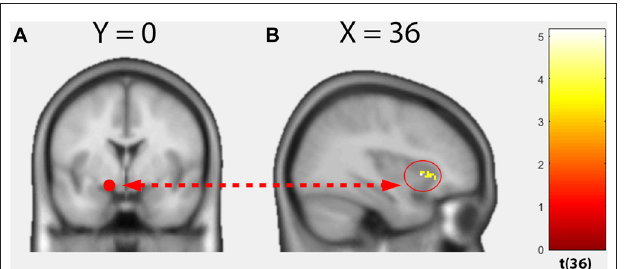
FIGURE 3 | Results of the voxel-wise regression psychophysiological- interactions (PPI) analysis. (A) Seed region, left dorsal amygdala. (B) Functional connectivity group difference varied as a function of the TSK score between the seed region and right anterior insula (Interaction 0 0 1 − 1; p < 0.05, cluster-level